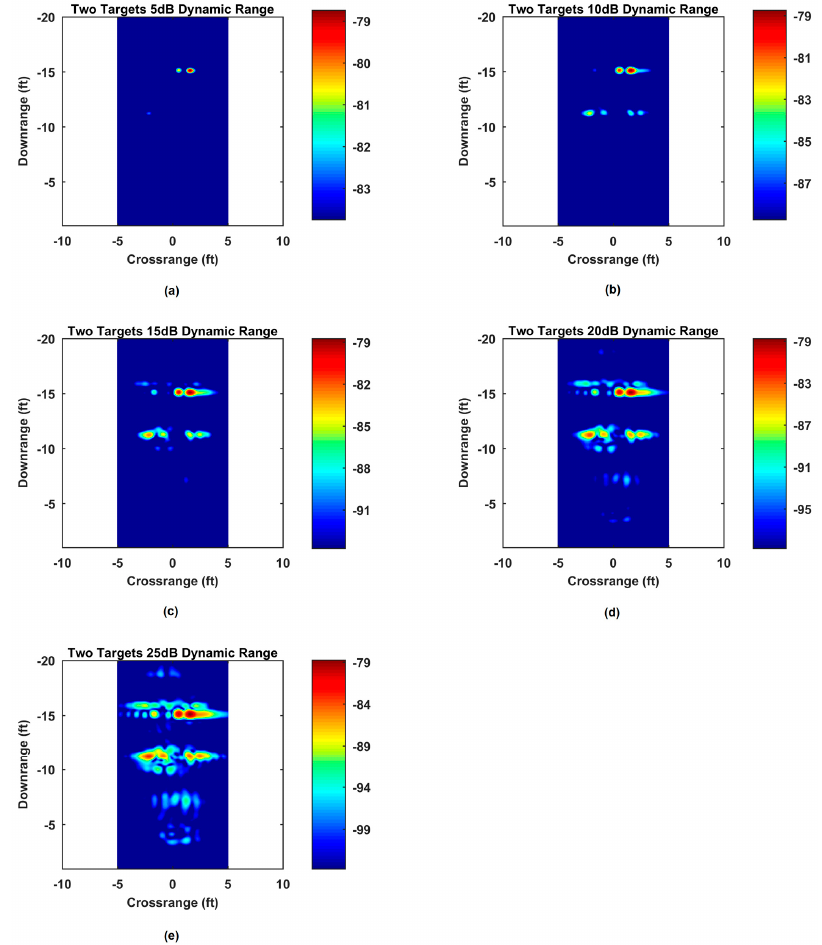
Figure 18. Images of a multiple targets at 3.35 m (11 feet) and 4.57 m (15 feet) down-range over 5–25 dB image dynamic range using SVD: ( a ) 5 dB; ( b ) 10 dB; ( c ) 15 dB; ( d ) 20 dB; ( e ) 25 dB.